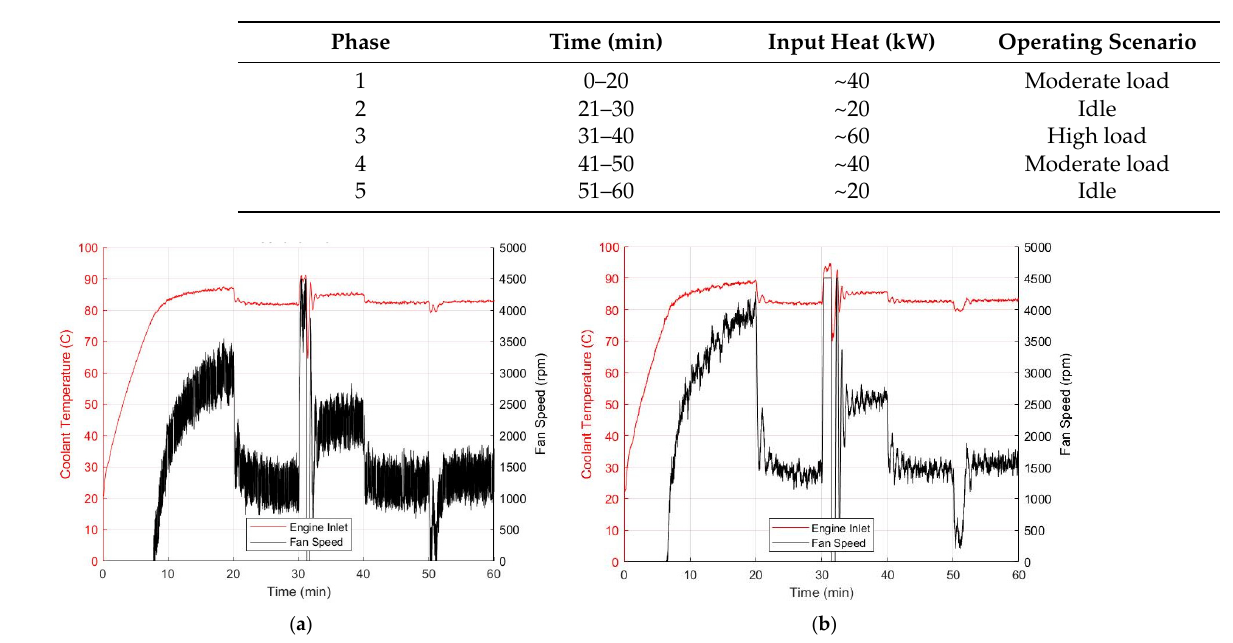
Table 3. Experiment phases showing the thermal load and fan speeds for the controller performance evaluation.